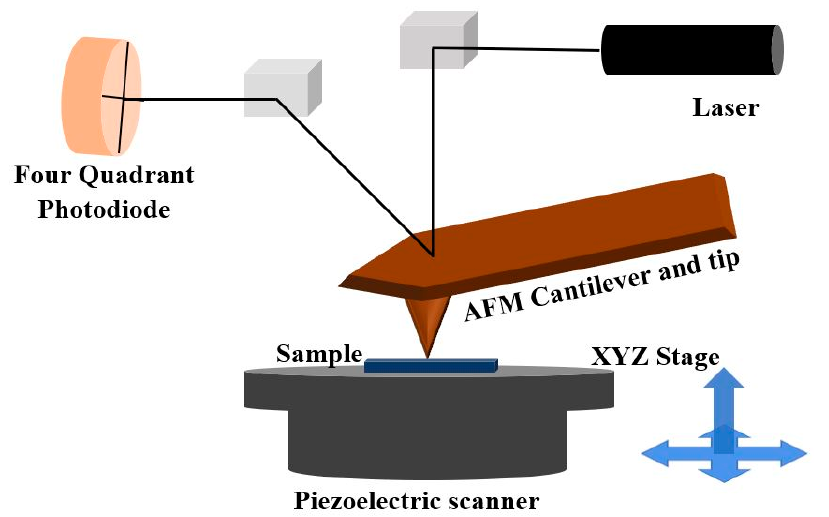
Figure 3. Schematic representation of an atomic force microscope.